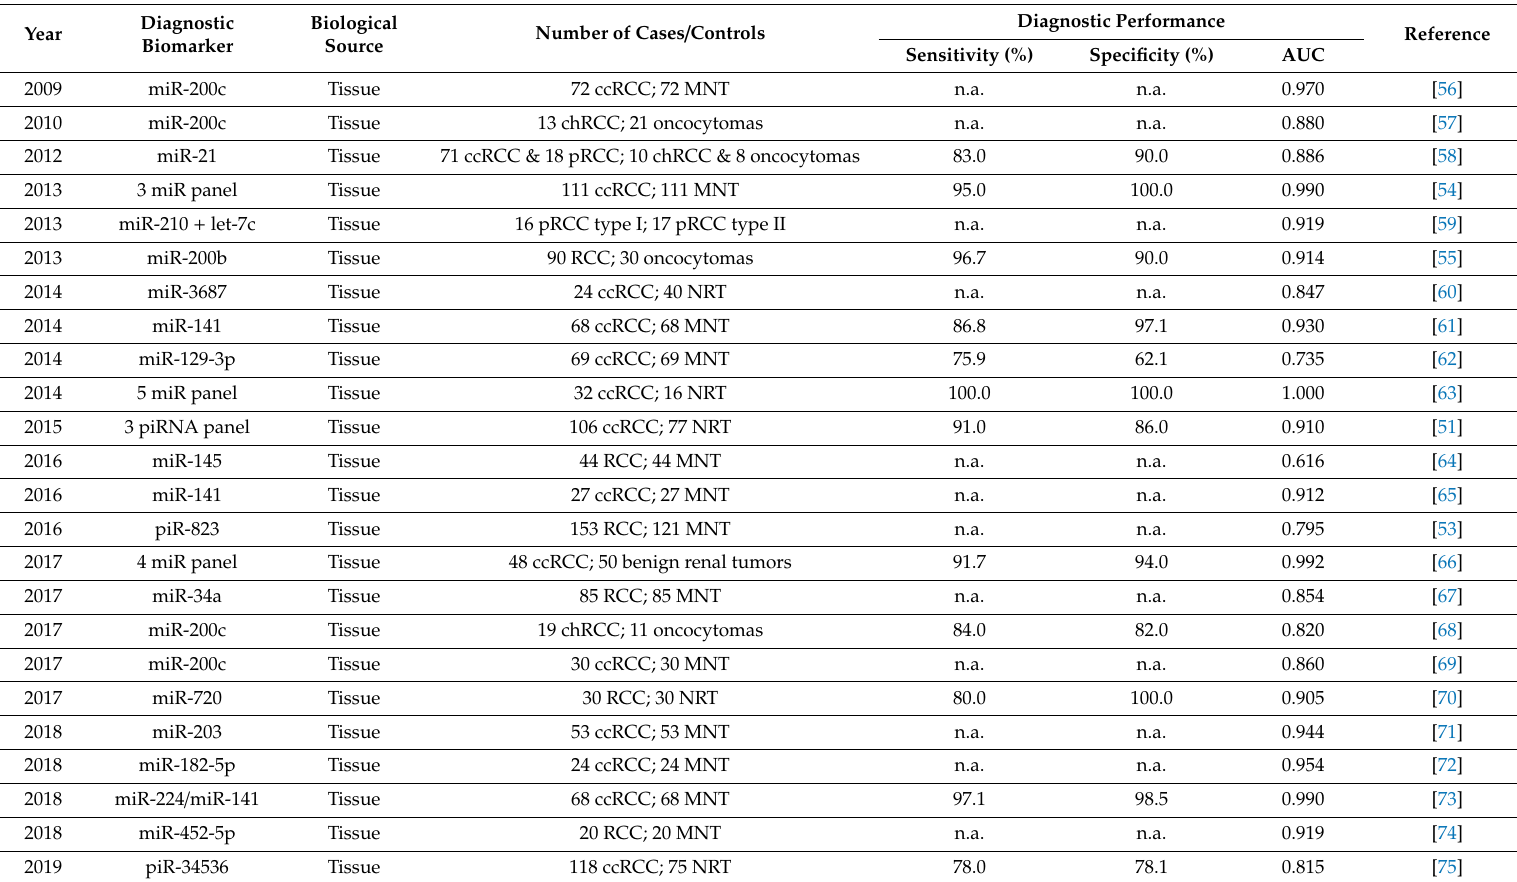
Table 1. Summary of proposed diagnostic biomarkers for Renal Cell Tumors (RCT) in